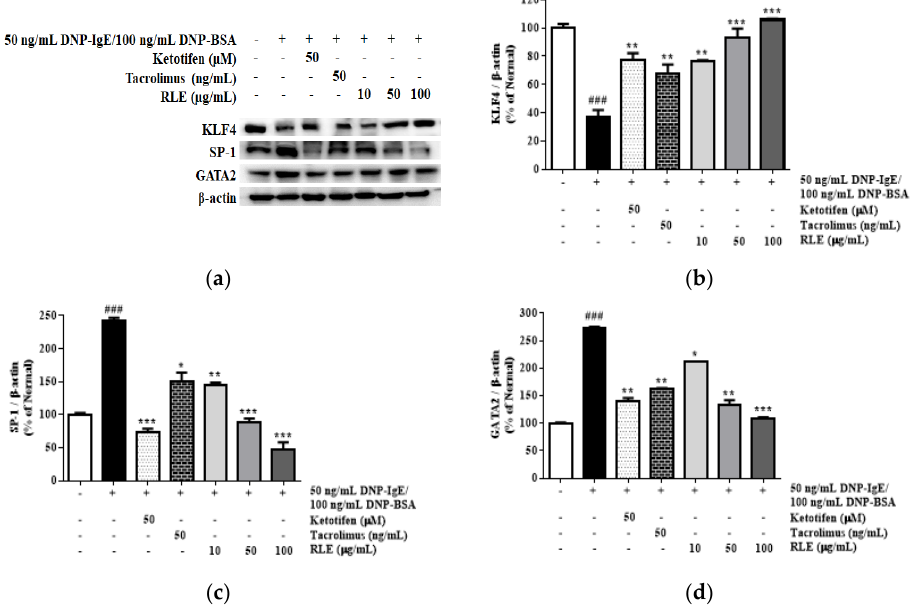
Figure 9. The effects of R. davurica Pall. leaf extract on the protein expression of kruppel-like factor (KLF) 4, specificity protein (SP) − 1, and GATA2 isolated from RBL − 2H3 cells. The protein levels were determined by western blot ( a ). The band intensities were quantified by densitometry, normalized to the level of KLF4 ( b ), SP − 1 ( c ), and GATA2 ( d ) calculated as the percentage of the non-treated group. Data are presented as the mean ± SD. * indicate significant differences between the non-treated cells and DNP-IgE/BSA-sensitized groups, respectively. ### p < 0.001 vs. the non-treated group. *, ** and *** p < 0.05, 0.01, and 0.001 vs. the DNP-IgE/BSA-sensitized control,